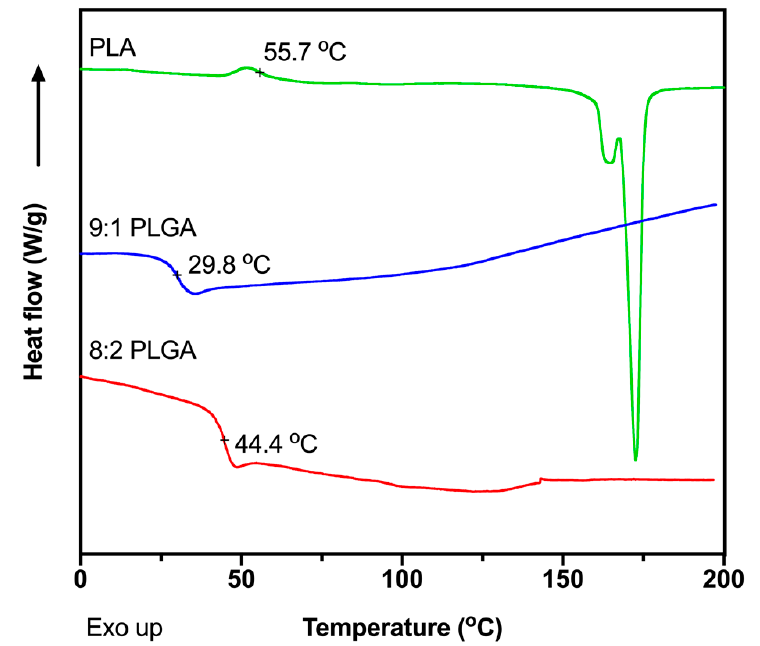
Figure 1. Differential scanning calorimeter (DSC) thermograms showing the second heating cycle for the of 8:2 PLGA, 9:1 PLGA and PLA polymers, recorded at a ramp rate of 10 °C/min.